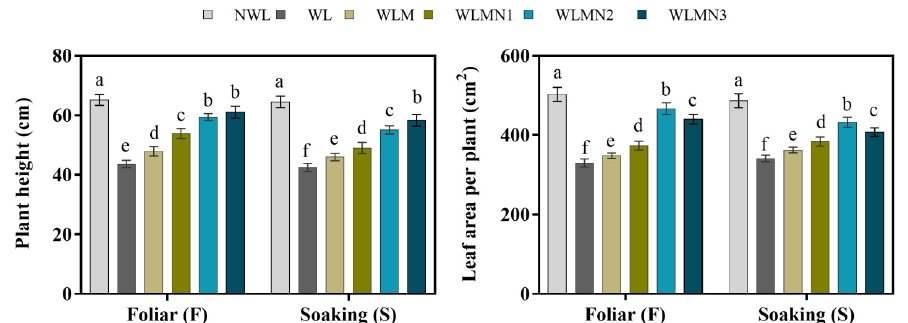
Figure 1. Effect of melatonin with KNO 3 on plant height and leaf area per plant (cm 2 ) of maize seedlings under waterlogging stress conditions. Data are presented as mean ± SD ( n = 3, biological replicates). Different small letters (a–e) in each column indicate significant differences at p ≤ 0.05 (least significant difference (LSD) test).The abbreviations of treatment names are the same as those described in Table 2.